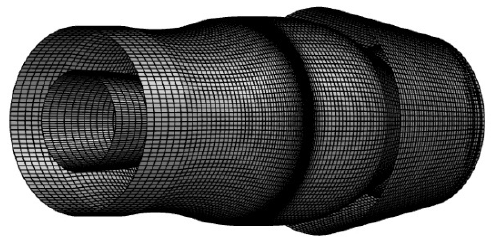
Figure 2. Nozzle structure grid.